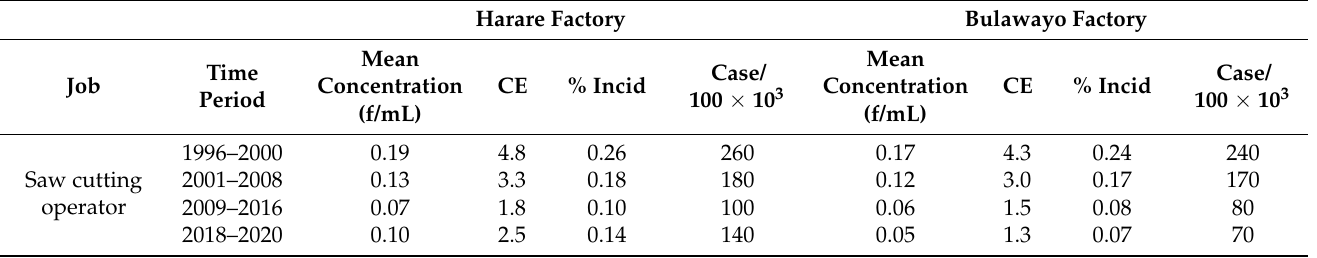
Table 4. Cumulative exposure and asbestosis incidence by time period and after 25 years of exposure. Harare